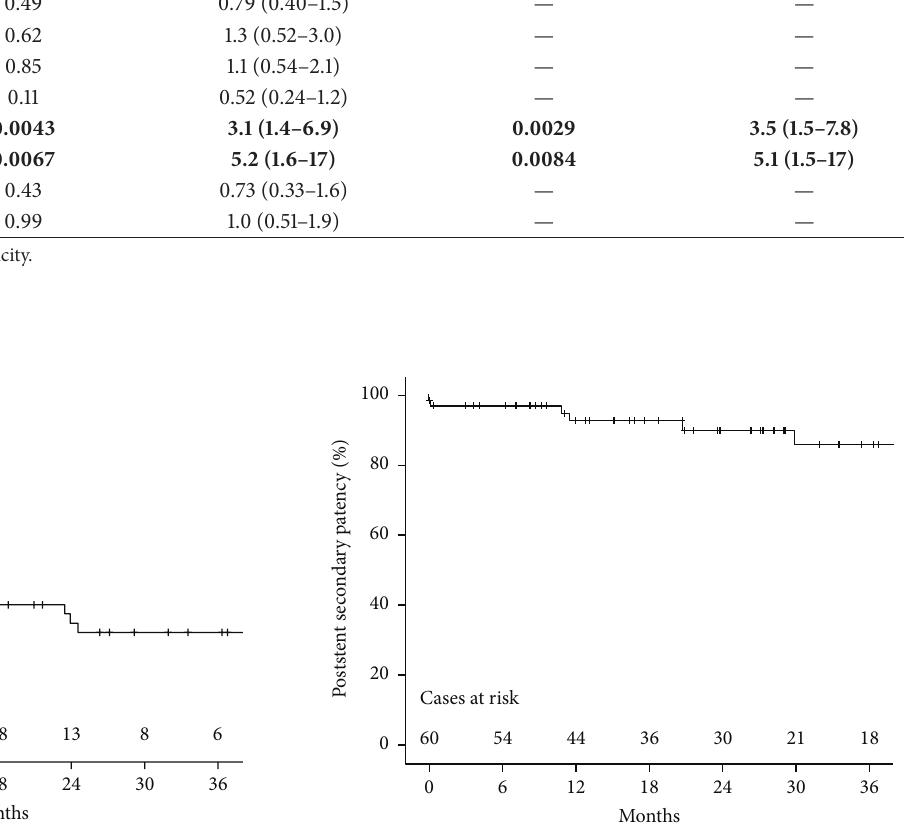
Figure 2: Kaplan-Meier estimate of postintervention primary patency after stent placement.